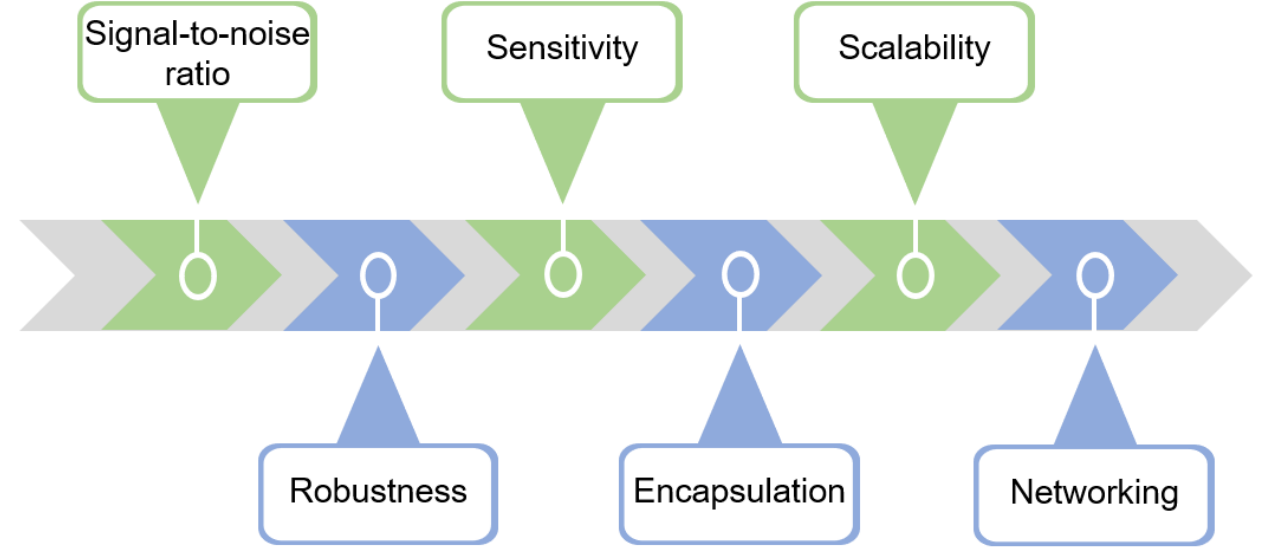
Figure 10. Perspectives of a TENG-based marine vibration sensor.